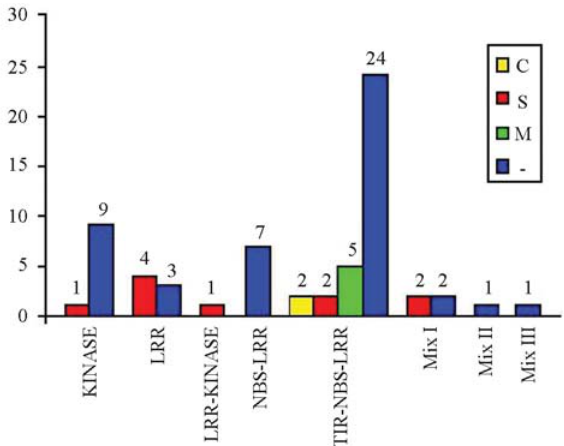
Table 4 - Inventory of the organisms that appeared as best alignment to each of the 210 here identified Eucalyptus clusters related to known resistance genes. The organisms are grouped by gene class (I to V and MIX I to III), taxonomic affiliation (class, subclass, family and species) andhabit(herbaceousorwoody).Numbersinparenthesisindicateamount of gene members in each taxonomic group or species.